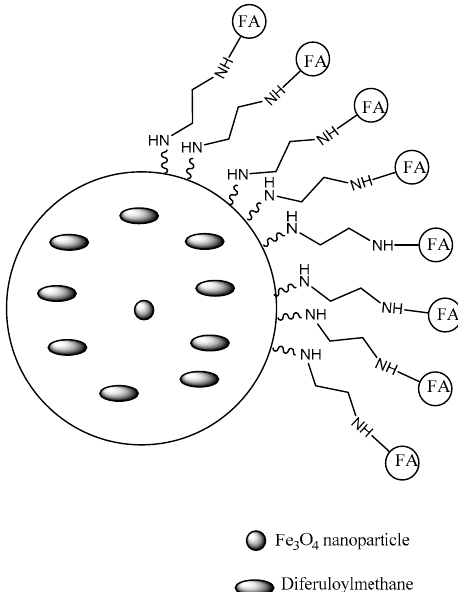
Figure 8. PAMAM dendrimer with SPION core encapsulated with diferuloylmethane and conjugated with FA [61].